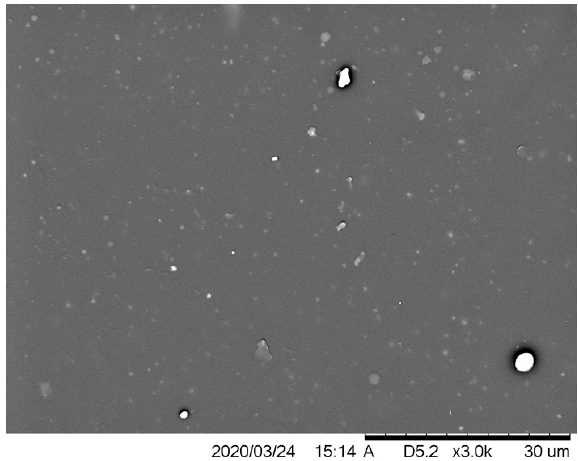
Figure 7. SEM image of the reference sample .